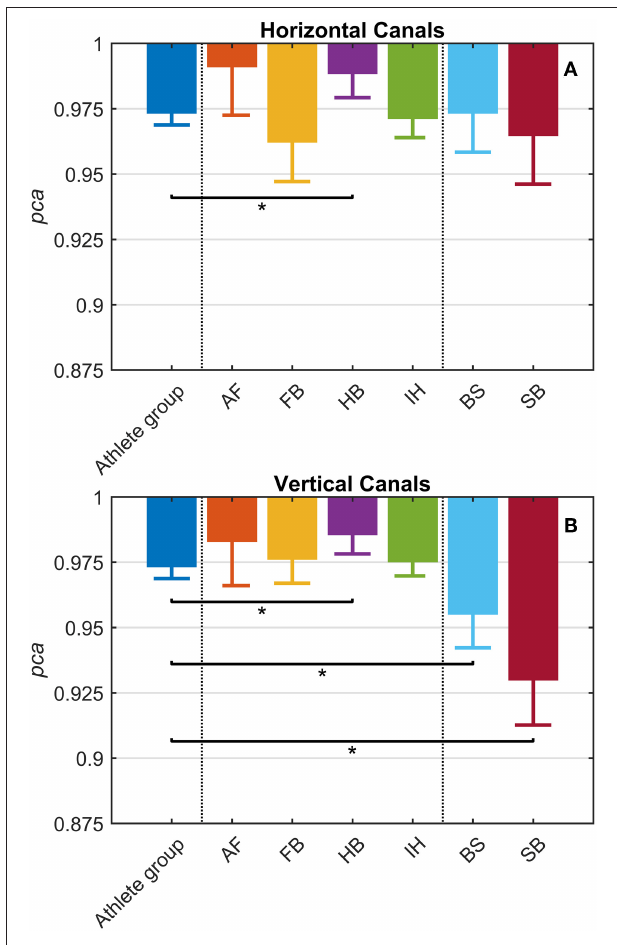
FIGURE 3 | Proportion of correct answers ( pca ) in the whole athlete group and single sport. AF, American Football; FB, Football; HB, Handball; IH, Ice Hockey; BS, Bob and Skeleton; SB, Snowboard. For ease of visualization, the dashed vertical lines separate the whole athlete group from the ball sports (first vertical line) and the non-ball sport (second vertical line). All pca were computed using the pooled approach (Equation 1) considering only head movements in the range of 2,001–6,000 deg/s 2 . Zeta distribution was used to estimate the lower bound of 95% confidence interval ( c.i. ) for pca, as the number of trials (i.e., head movements) was large enough ( >> 200). The asterisk (*) represents the statistically significant comparisons ( p -value < α bonf = 0.0083). (A) Horizontal canals. HB players (violet bar) showed a significant higher fHIT performance ( pca > 0.975) respect to the whole athlete group (dark blue bar). (B) Vertical canals. The fHIT performance in vertical canal was clearly lower pca in the non-ball sport players (i.e., BS and SB, respectively the light blue and dark red bar) respect to the whole athlete group . HB player, instead, confirmed the same finding for the horizontal canals, achieving a higher pca for impulses performed in the vertical canals as well.